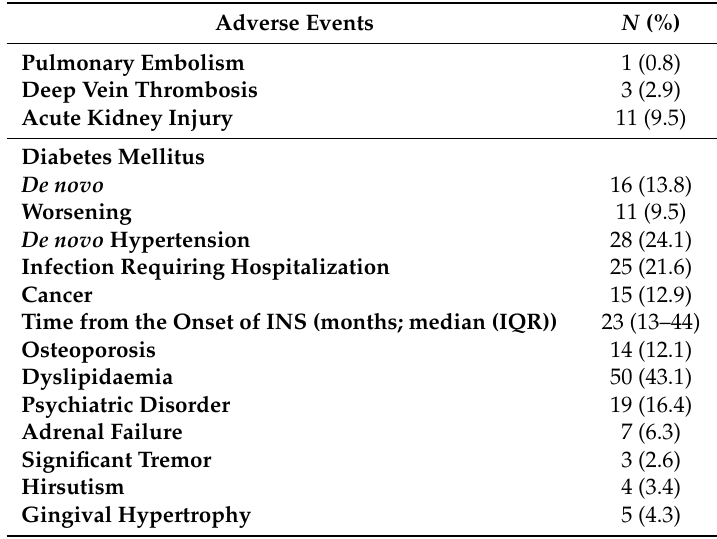
Table 4. Main Adverse Events Occurring During the Follow-Up. INS , idiopathic nephrotic syndrome; IQR , interquartile